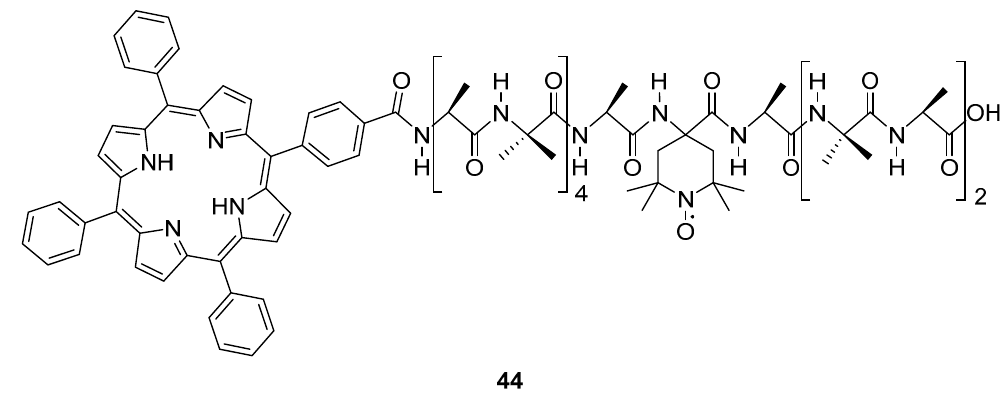
Figure 10. Chemical structure of the bis-labelled peptide TPP-(Ala-Aib) 4 -Ala-TOAC-Ala- (Aib-Ala) 2 -OH 44